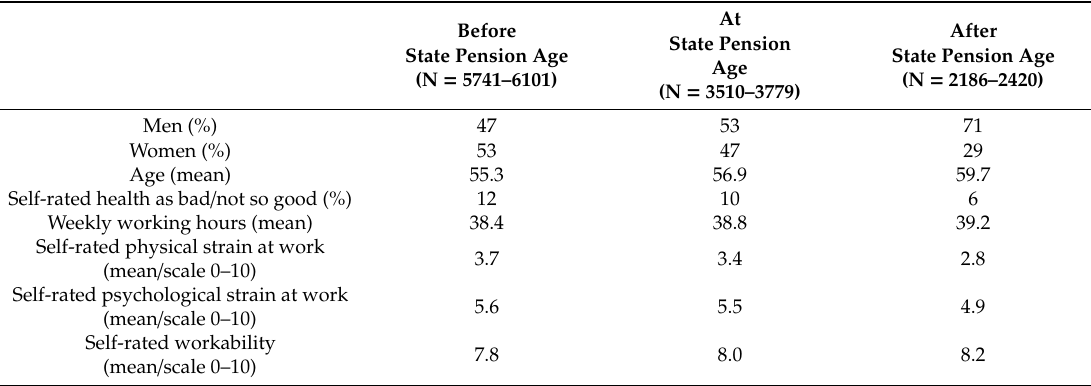
Table 1. Background information for the three retirement